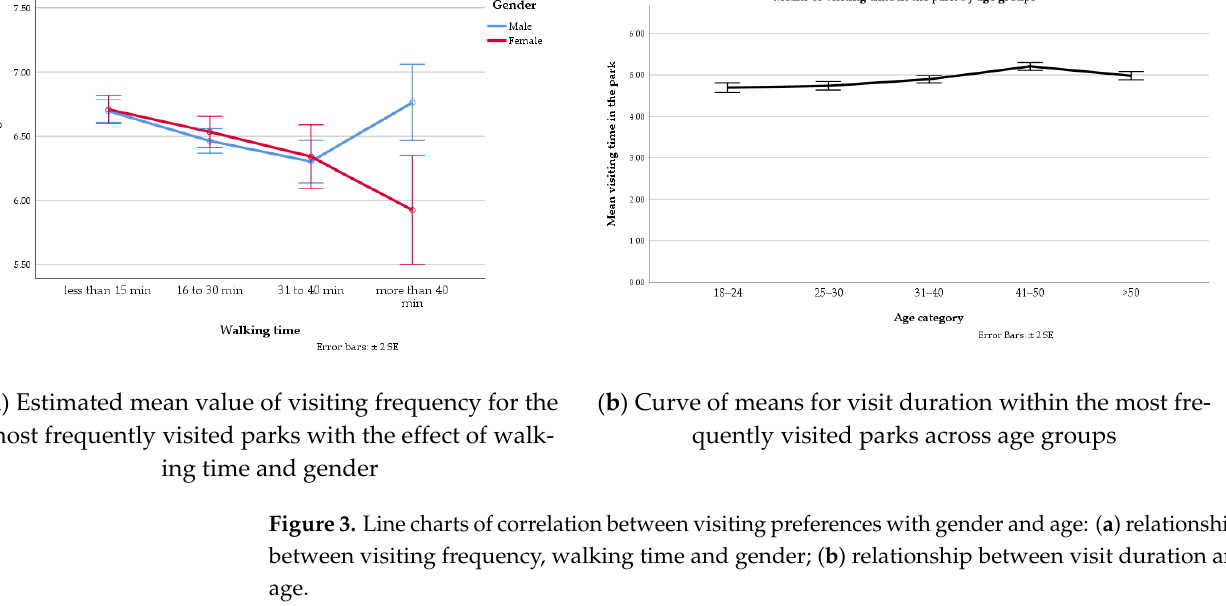
Figure 3. Line charts of correlation between visiting preferences with gender and age: ( a ) relationships between visiting frequency, walking time and gender; ( b ) relationship between visit duration and age.